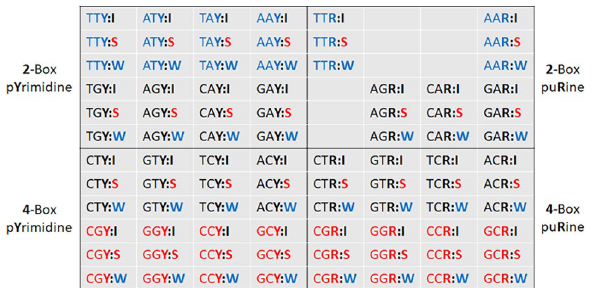
Figure 1. Overview of heatmap structure for assessment of third nucleotide bias in codon pairs. Codon-pairs are show as the first codon (three nucleotides) separated by a colon from the second codon type ( I , S or W according to network interaction characteristics). The codons are colored according to network interaction characteristics: blue for ‘weak’, black for ‘intermediate’, and red for ‘strong’. Each datapoint in the heatmaps show the preferred third nucleotide for the first codon. The ratio of the third position nucleotides is shown as the greater of —( T / C ) or —( C / T ) when the third nucleotide is a pyrimidine ( Y , left quadrants) and the greater of —( A / G ) or —( G / A ) when the third nucleotide is a purine ( R , right quadrants) and shaded green or red respectively. 2-box codons are in the two upper quadrants and 4-box codons are in the two lower